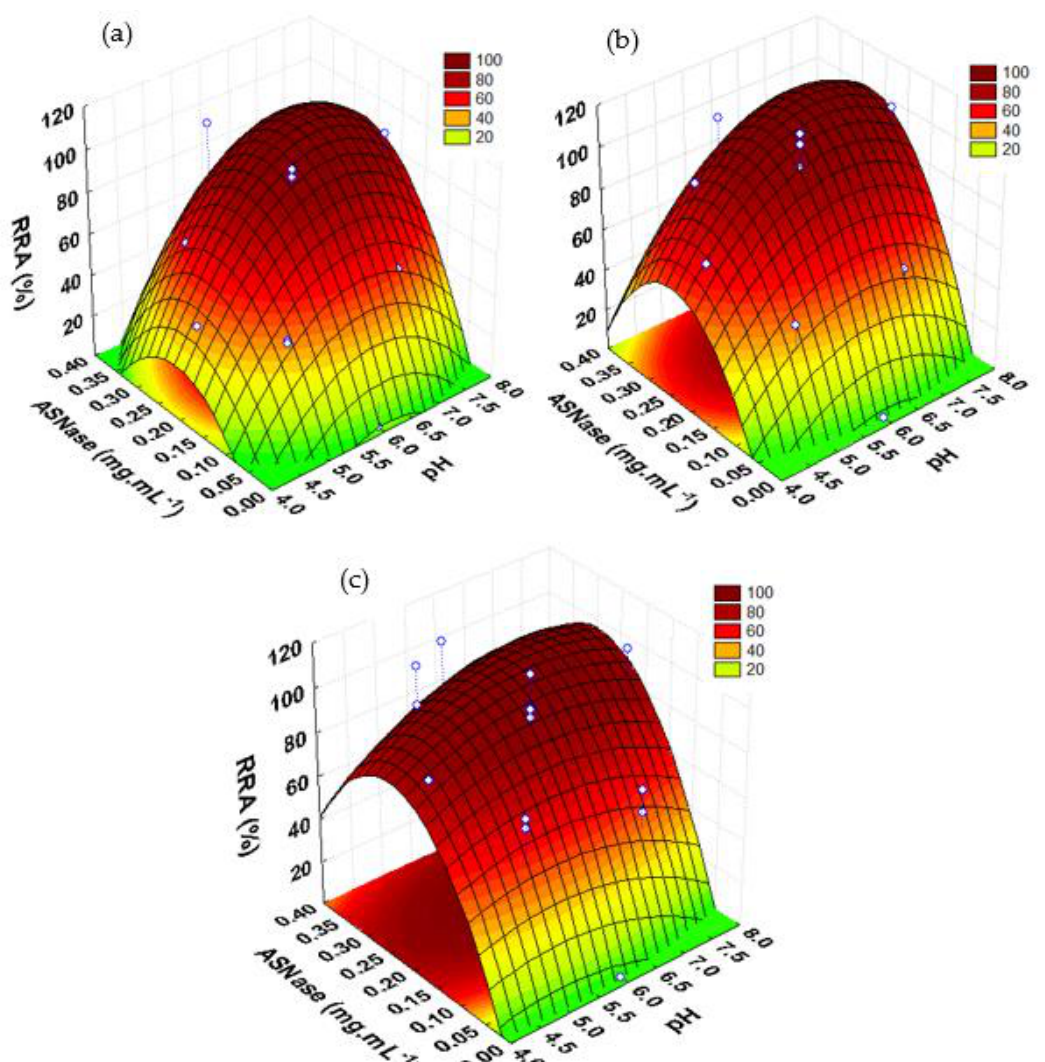
Figure 4. Response surface plots for RRA of immobilized ASNase over CX as a function of enzyme concentration and pH, for a contact time of 60 min. ( a ) CX-4; ( b ) CX-13; ( c ) CX-30.